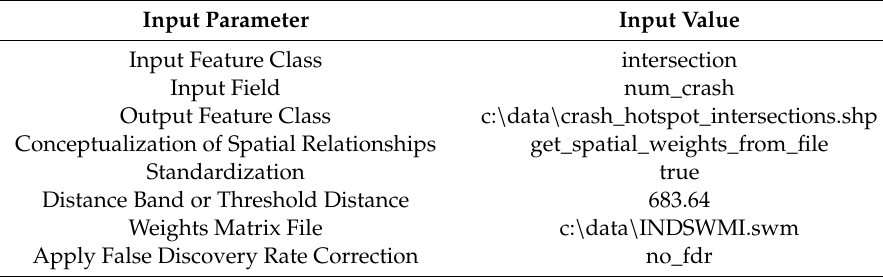
Table 4. Input parameters of intersection hotspot